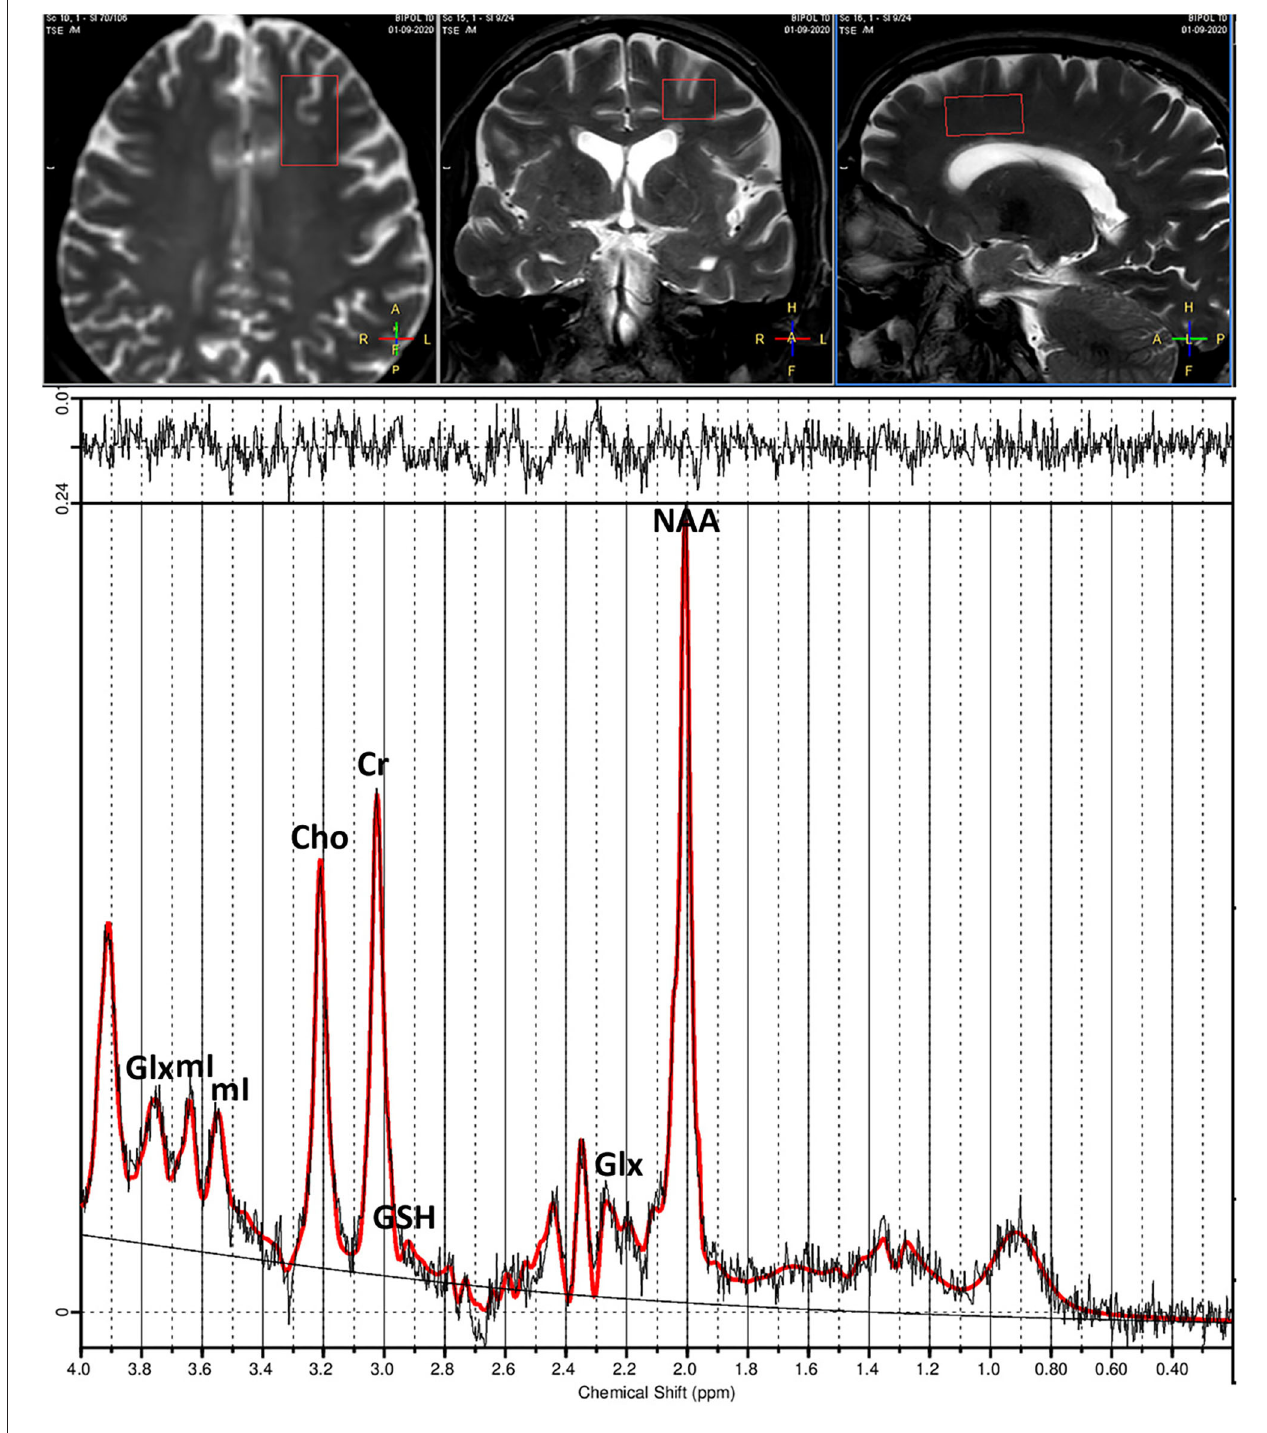
FIGURE 1 | (Top) T1-weighted images show placement of voxel in anterior cingulate cortex (ACC). (Bottom) Example of proton spectra from ACC and peak intensities of brain metabolites. Glx, Glutamate+Glutamine; mI, myo-inositol; Cho, choline; Cr, creatine; GSH, glutathione; NAA, N-acetylaspartate.